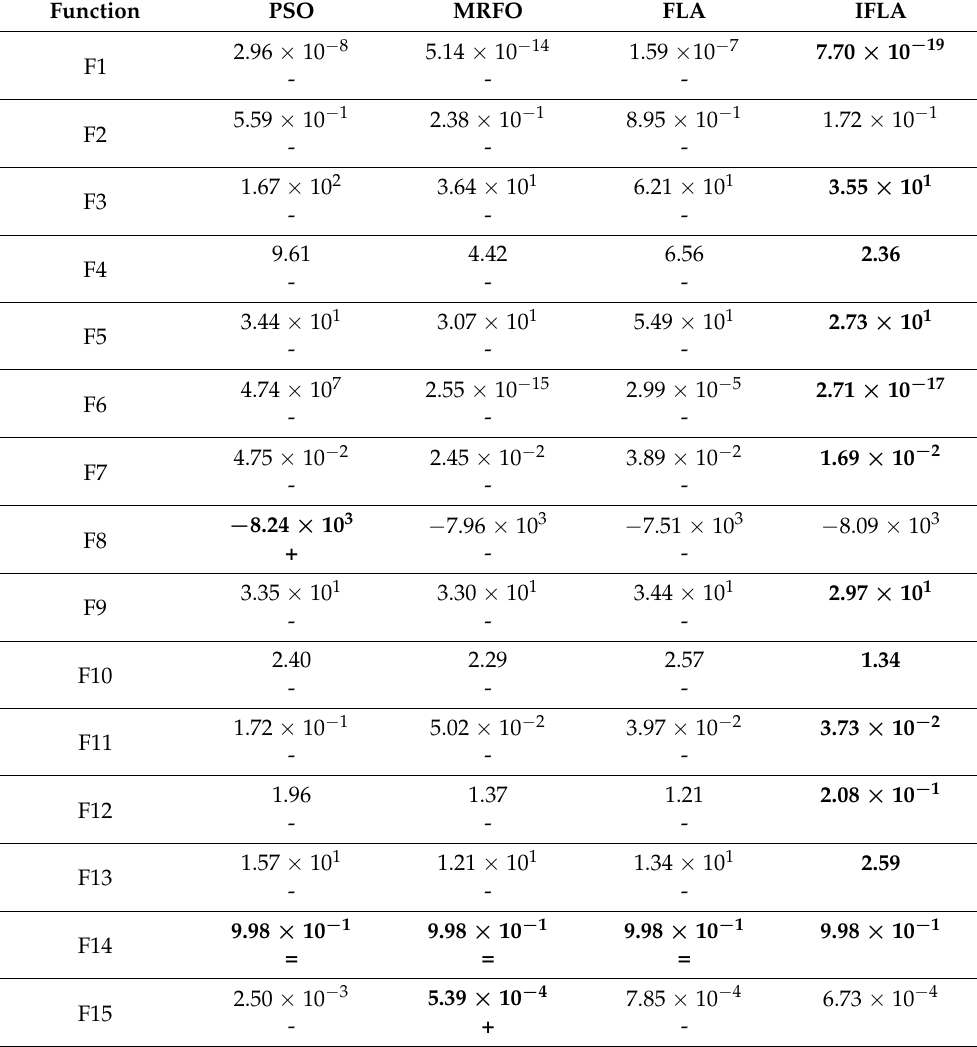
Table 2. Mean results for classic test functions when adopting PSO, MRFO, FLA, and IFLA (the significant values are marked in